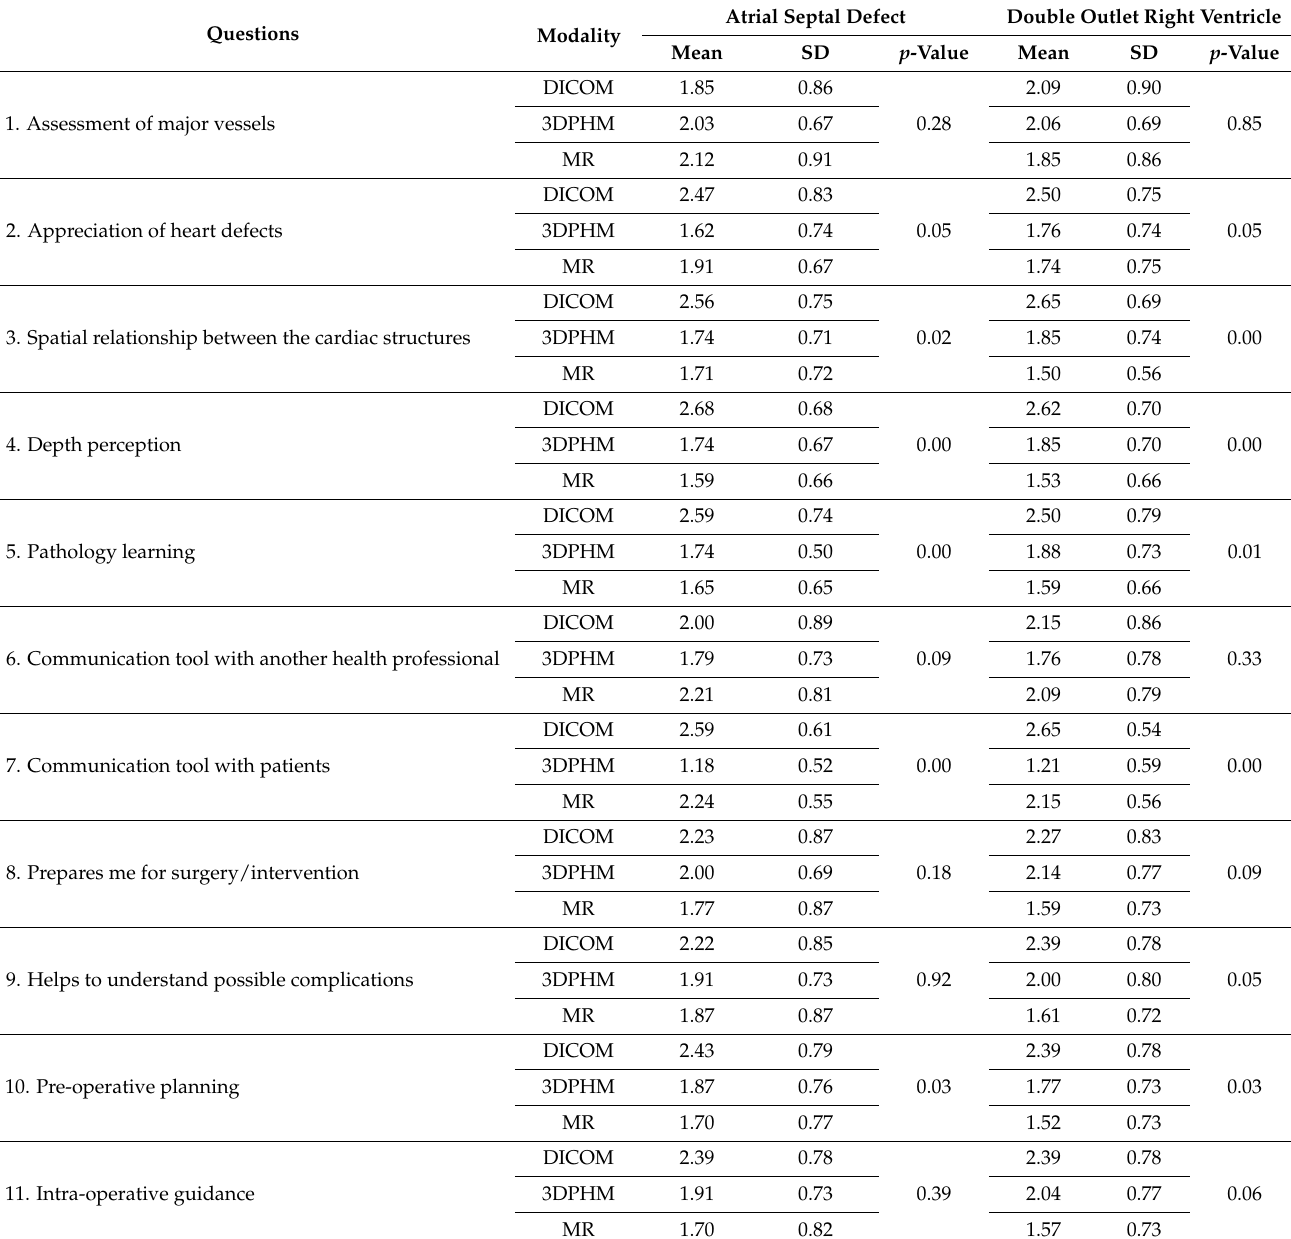
respective p -values. Table 4 presents the mean differences in the responses between the two occupation groups, interventionalists and non-interventionalists. The result shows that there are no significant differences in their responses. Table 2. The mean rank of different modalities for each